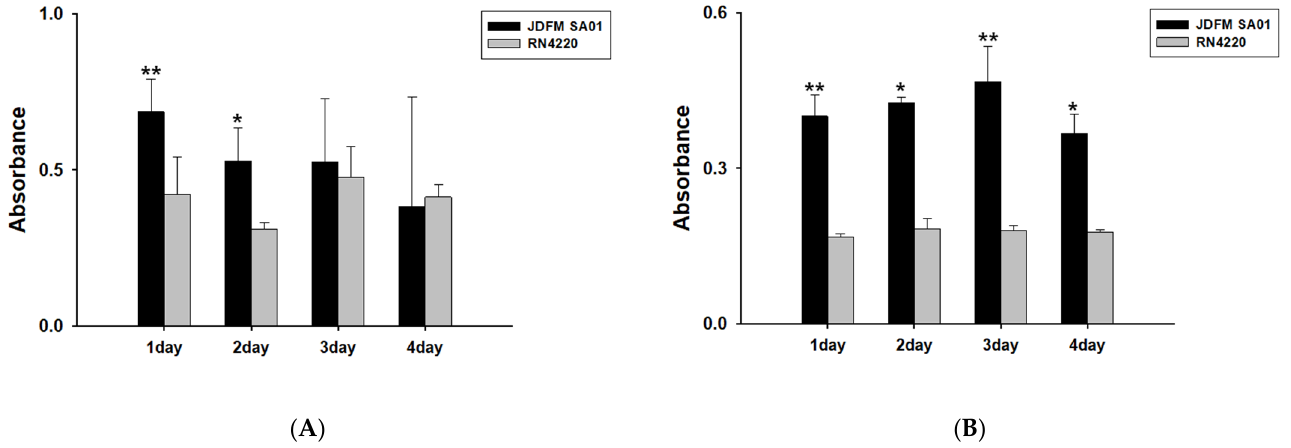
Figure 2. Evaluation of the biofilm formation ability of S. aureus JDFM SA01 strains. ( A ) 0.5× LB broth, ( B ) 0.1× LB broth. Statistical significance was analyzed with a t-test. Asterisks indicate a statistically significant difference compared with RN4220 ( * p < 0.05, ** p < 0.01).